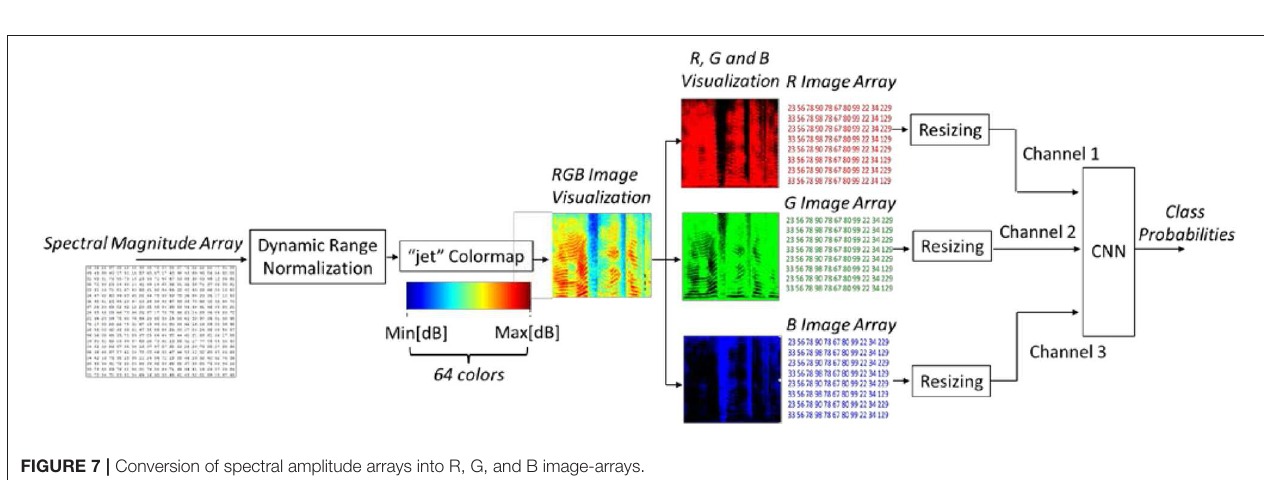
FIGURE 7 | Conversion of spectral amplitude arrays into R, G, and B image-arrays.